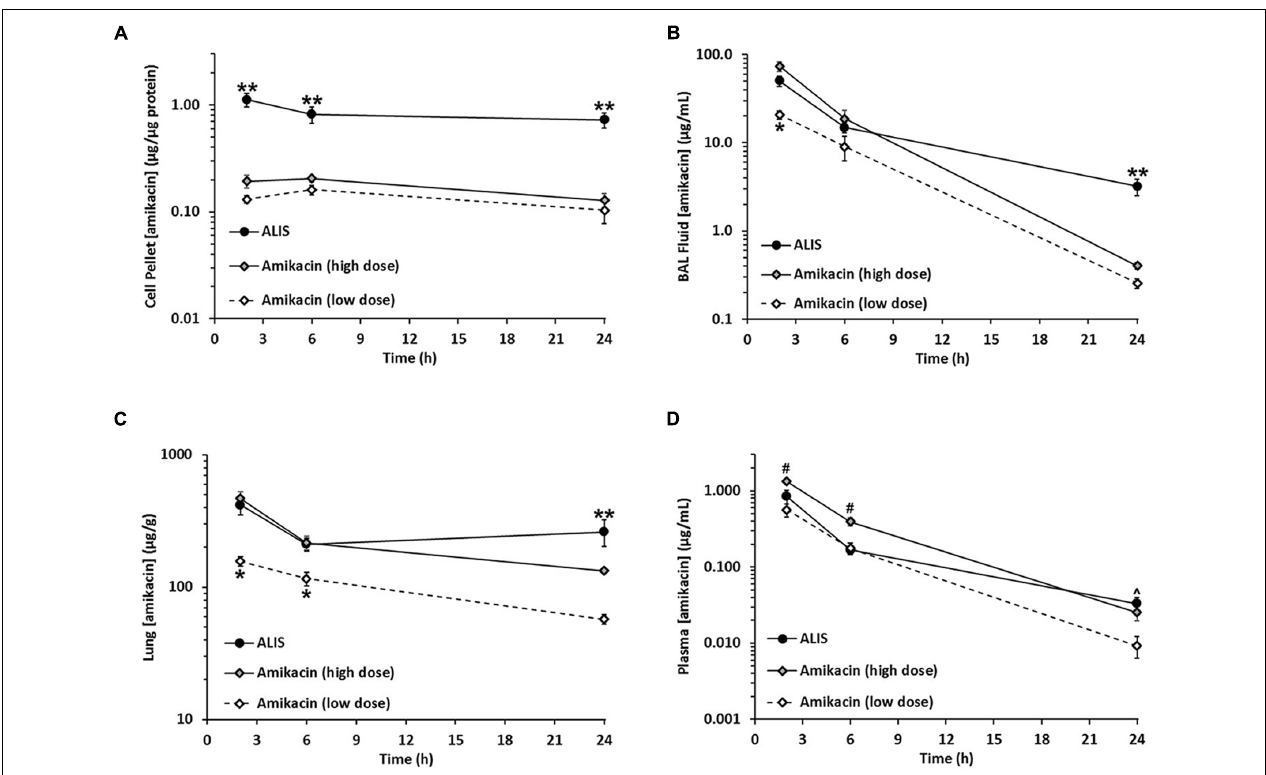
FIGURE 6 | Amikacin liposome inhalation suspension (ALIS) enhanced amikacin uptake into macrophages and retained more amikacin in airways and lung tissue. Rats were administered either ALIS or free amikacin by nebulization and BAL cells (representing > 80% macrophages) (A) , BAL fluid (B) , lungs (C) , and plasma (D) were collected at 2, 6, or 24 h after the end of nebulization. Amikacin concentrations were quantified by LC-MS/MS. The delivered and deposited doses for each group are presented in Table 2 . ∗ P < 0.05 vs. both high-dose amikacin and ALIS groups. ∗∗ P < 0.05 vs. both low and high-dose amikacin groups. # P < 0.05 vs. both ALIS and low-dose amikacin groups. ˆ P < 0.05 vs. the low-dose amikacin group. n = 8 rats per group.